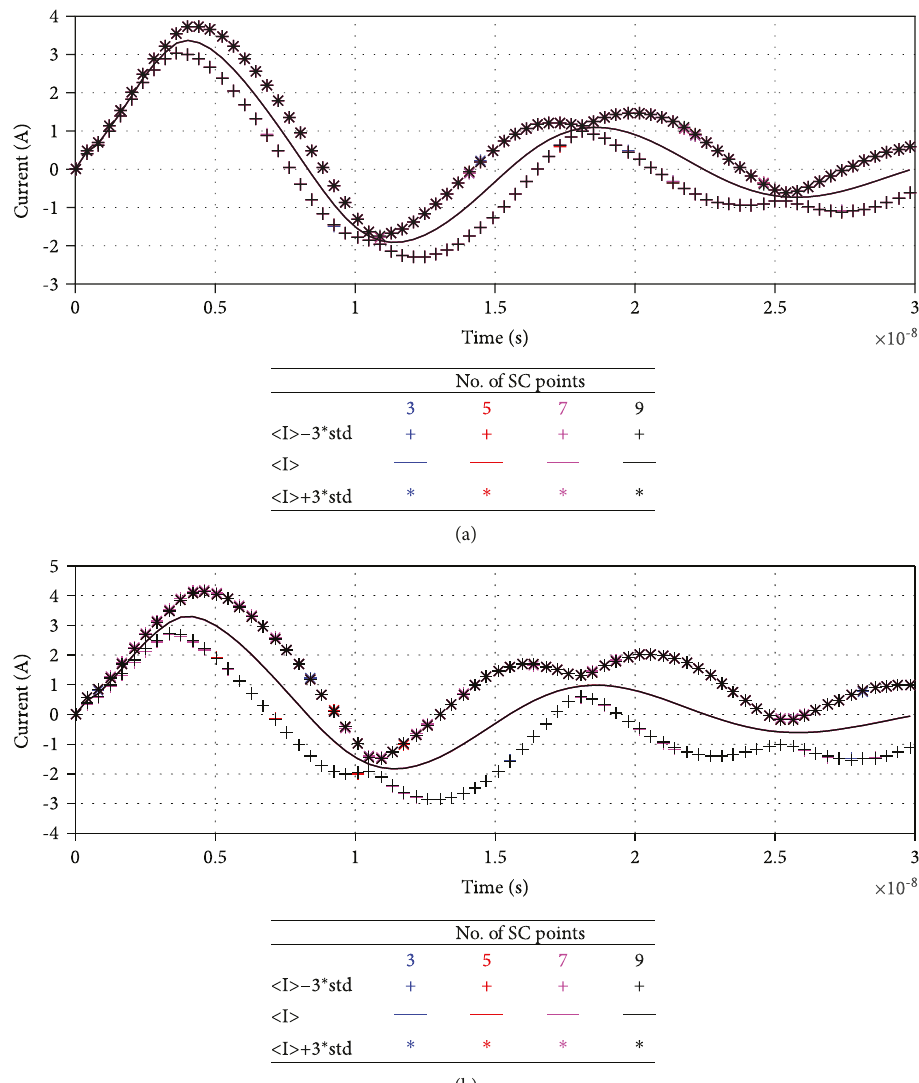
Figure 2: The stochastic transient current induced in the human body exposed to the double-exponential EMP. The observation point is the middle point of the antenna. The stochastic mean is denoted with < I > and std stands for standard deviation. (a) The coe ffi cient of variation CF = 5 71 %; (b) CF = 12